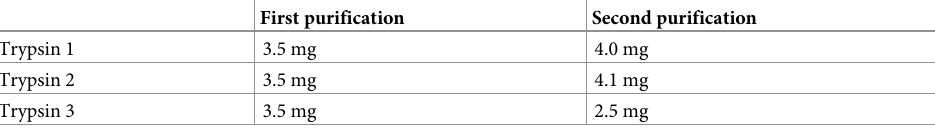
Table 1. Purification